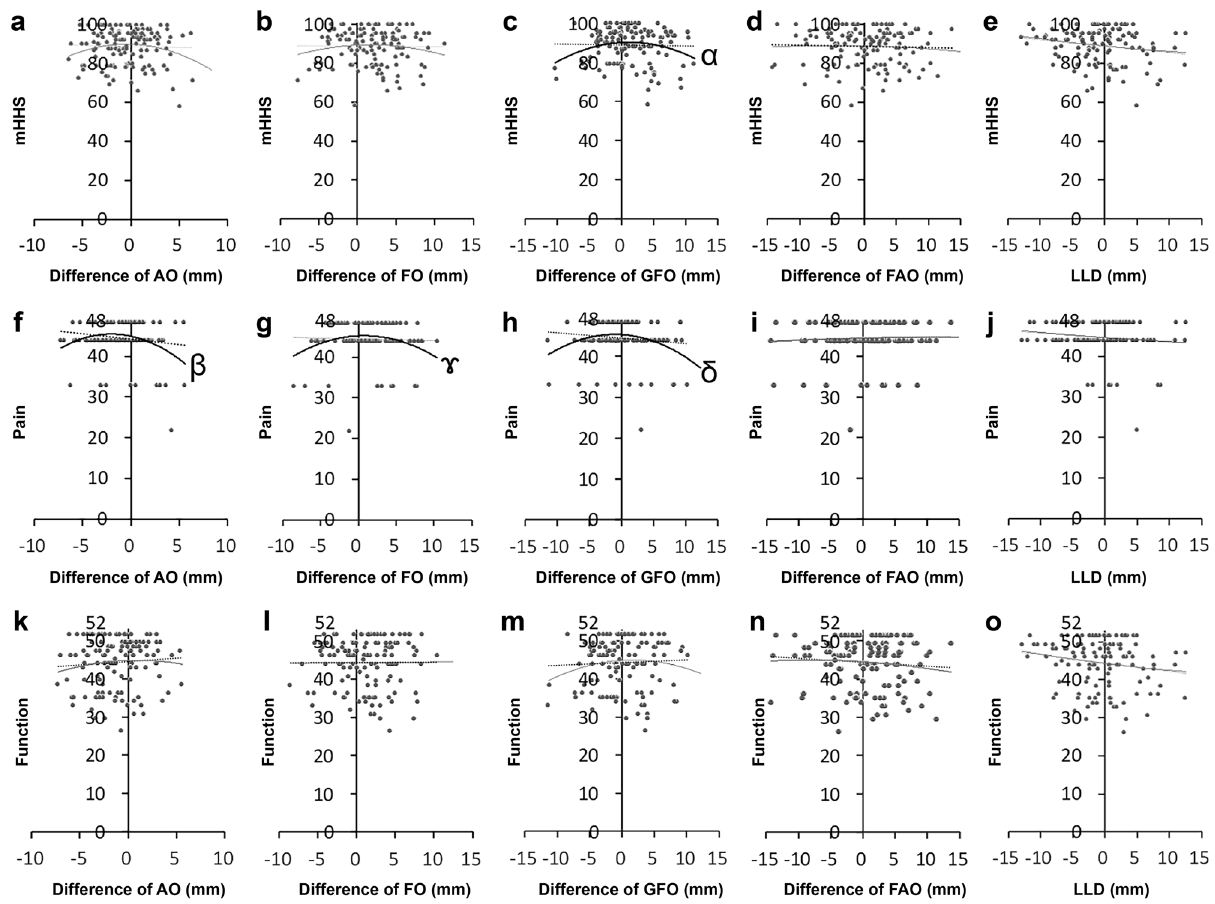
Figure 5. Binomial approximation and maximum value. We evaluated using binomial approximation, and the maximum value of any significant association was determined. Panels ( a – e ) show plots of mHHS versus the differences in AO, FO, GFO, FAO, and LLD, respectively. Panels ( f , g , h , i , k , l ) show plots of pain versus the differences in AO, FO, GFO, FAO, and LLD, respectively. Panels ( k – o ) show plots of the function versus the differences in AO, FO, GFO, FAO, and LLD, respectively. There was a significant correlation in panels ( c , f , g , h ). There was no significant correlation in panels ( a , b , d , e , i – o ).